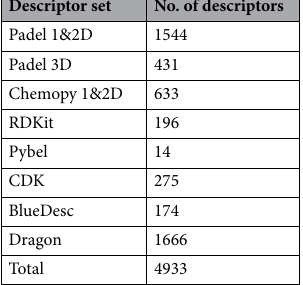
Table 7. Descriptor sets.